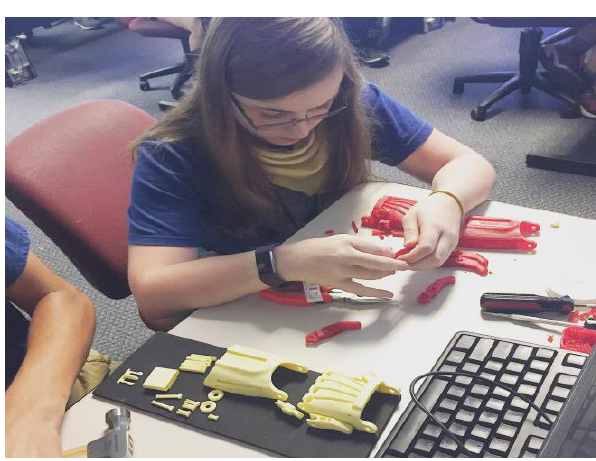
Table 1: Overview of survey contents Figure 1: Volunteer assembling a 3D- printed prosthetic device